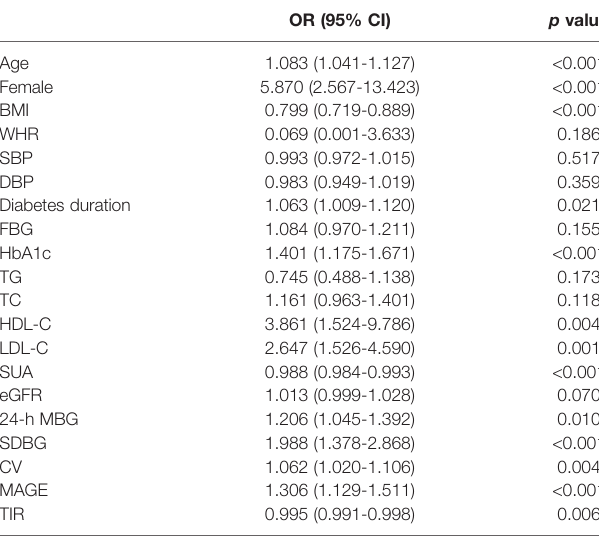
TABLE 2 | Univariate logistic regression analysis to explore potential factors for osteoporosis in T2DM patients. OR (95% CI) p value